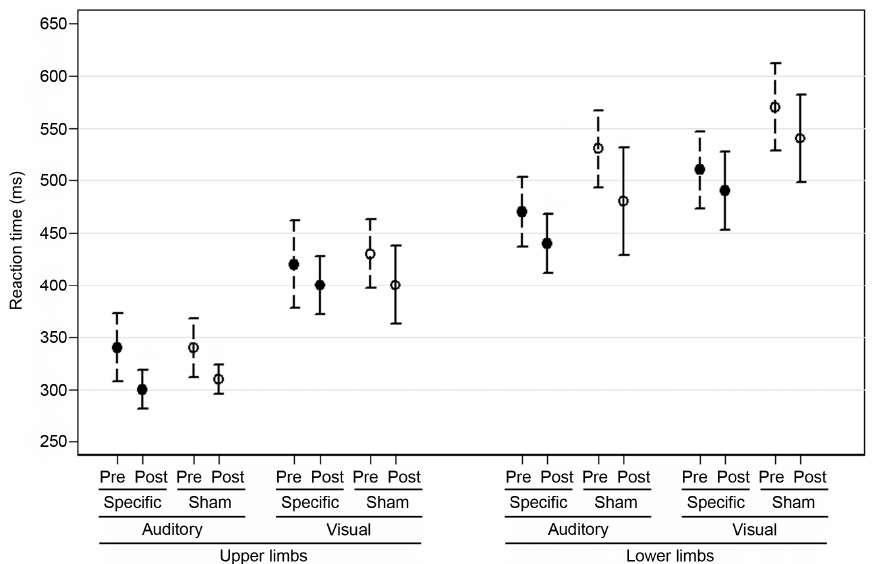
Figure 1. Reaction times to visual and auditory stimuli for upper and lower limbs in the experimental (specific VO / MI) and control (sham VO / MI) groups. Data are reported in milliseconds as a mean and 95% confidence interval. Solid circle indicates experimental group (specific intervention), hollow circle indicates control group (sham intervention).